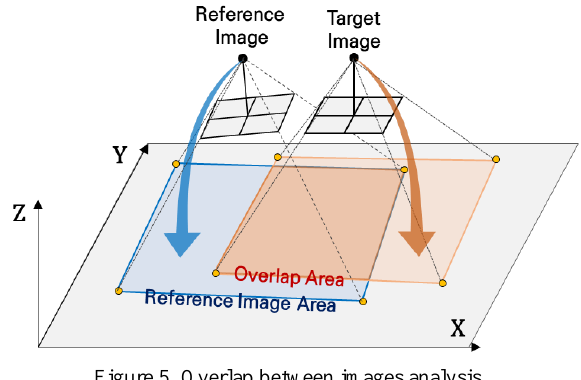
Figure 5. Overlap between images analysis